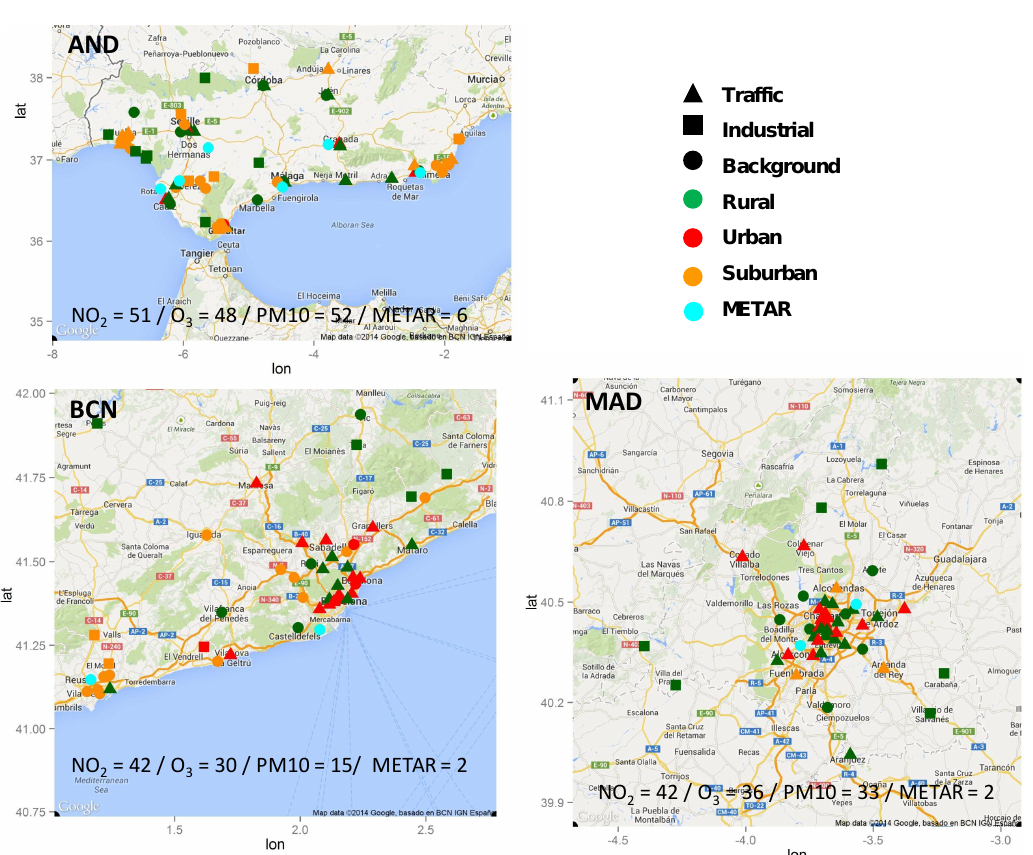
Figure 2. Air quality stations for NO 2 , O 3 and PM 10 in the three domains under study (AND, BCN and MAD) in April 2013. Different types of stations are shown by symbols and color codes. The various symbols represent the major emission type affecting each station (Traffic: triangle; Industrial: square; and Background: circle), while the colors reflect the environment of each station (Urban: red; Suburban: green; and Rural: orange). Cyan dots represent the METAR stations used in Sect. S1 in the Supplement.